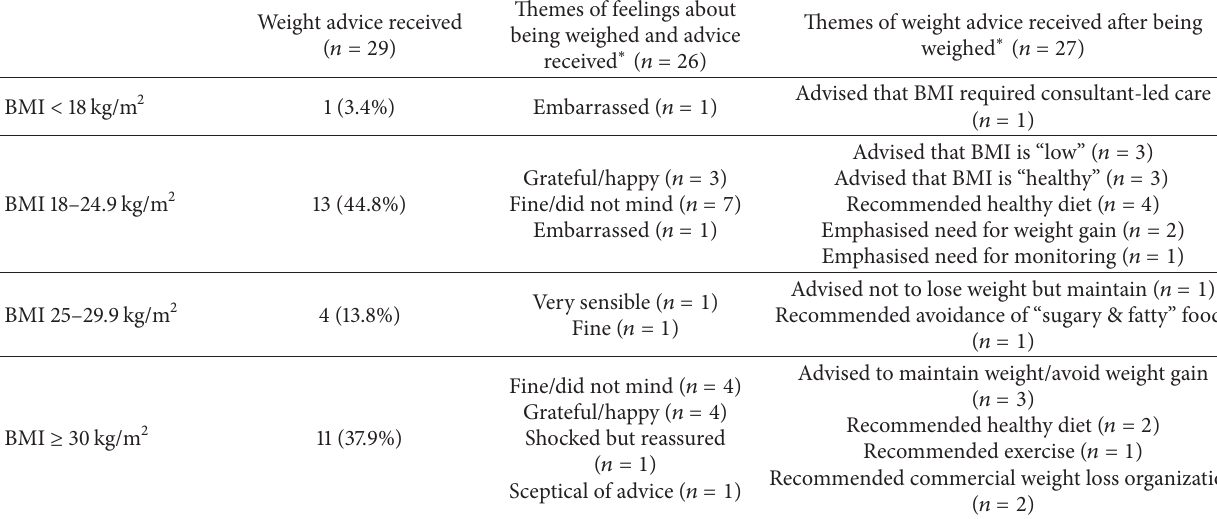
Table 2: Weight advice received by participants after being weighed, by BMI classification at recruitment.